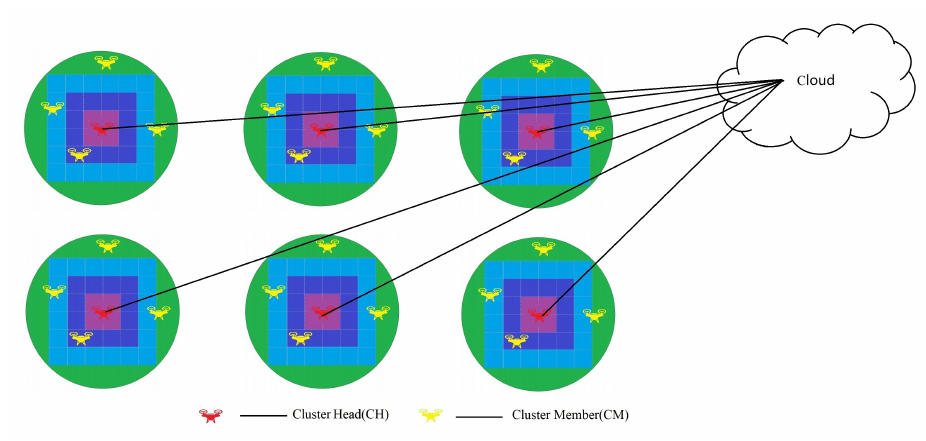
Figure 1. The system model.